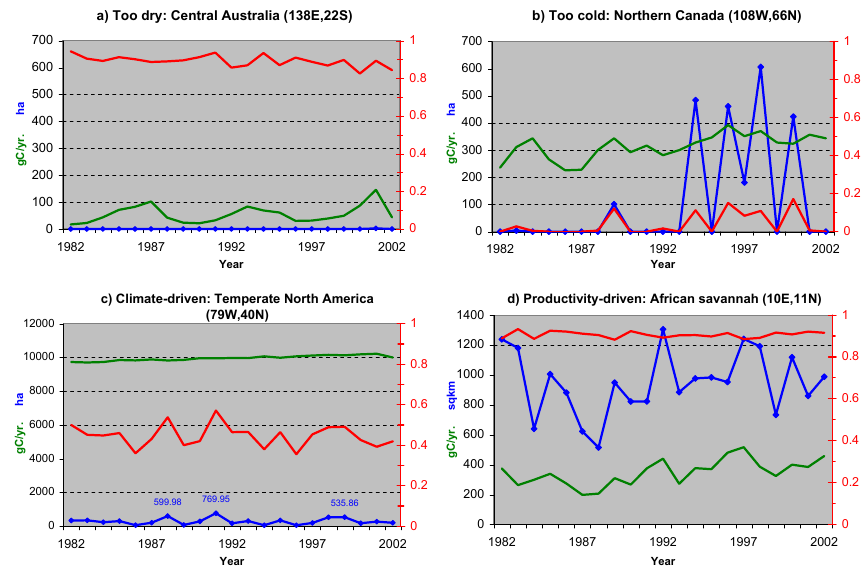
Fig. 4. Grid cell analysis of fuel vs. climate dynamics that determine area burnt in selected biomes 1982–2002; primary axis: annual area burnt (blue; please note different unit for panel (d) ) and annual aboveground biomass (green); secondary axis: annual fire danger index (red).